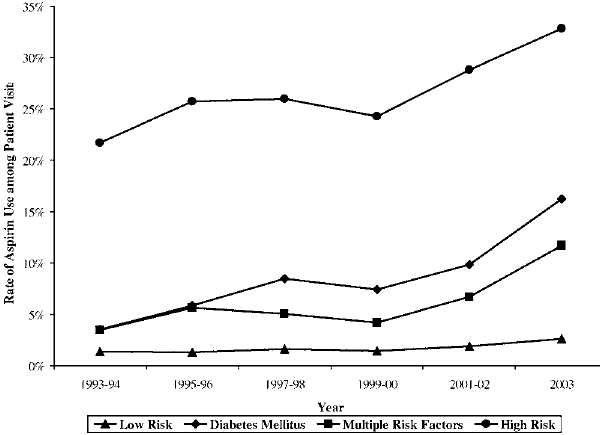
Figure 1. National Trends in Aspirin Use in Patient Visits Defined as Low Risk, Intermediate Risk, DM, or High Risk DOI: